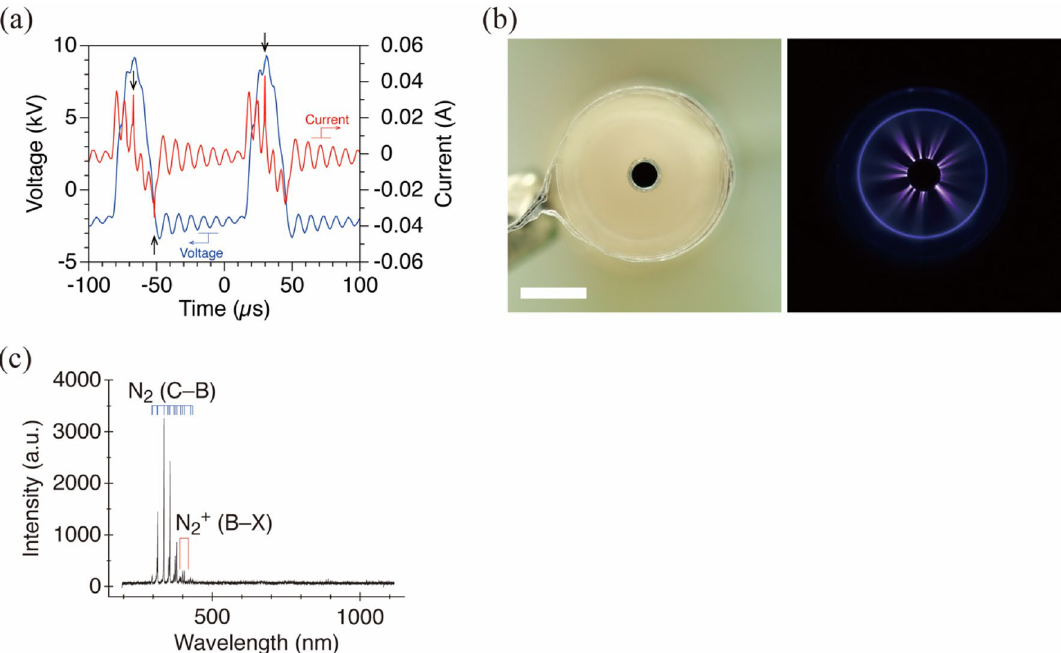
Figure 2. Characteristics of plasma generated by the DBD. ( a ) Waveforms of the applied voltage (blue) and discharge current (red). Black arrows indicate discharge current pulses. ( b ) Light emitted by plasma generated in the electrode unit when no solution was infused. Scale bar, 3 mm. ( c ) Emission spectrum of the plasma discharge. Typical peaks are attributed to the N 2 -SPS(C–B) and N 2 +